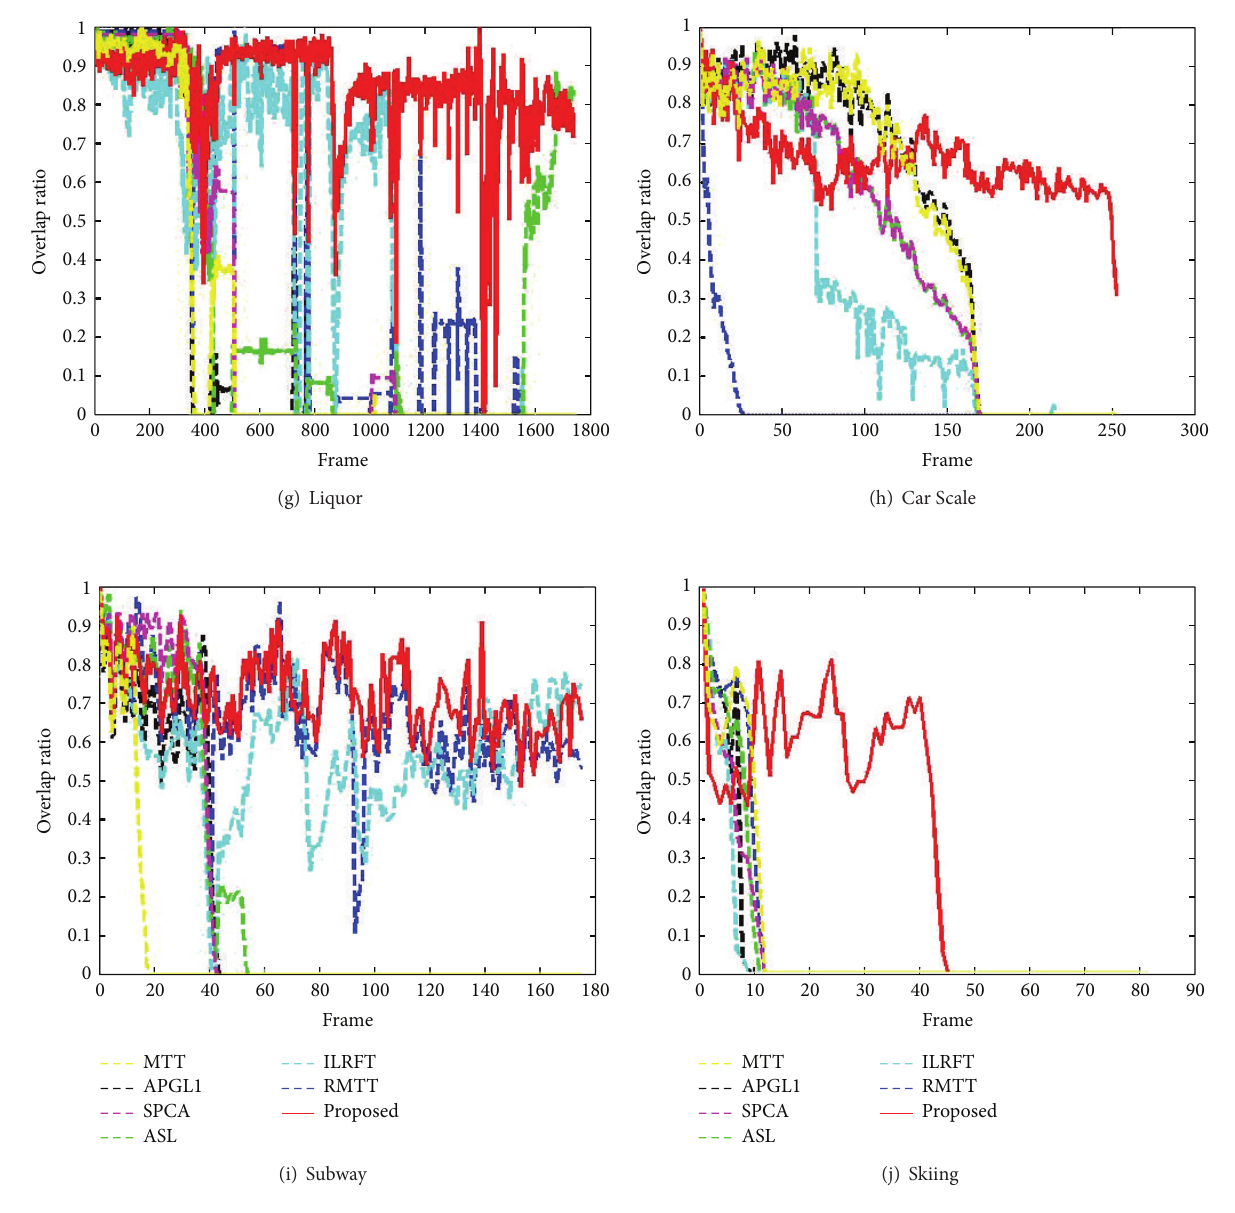
Figure 2: Overlap ratio evaluation. This figure shows overlap ratios for ten test sequences. The proposed method is compared with six state- of-the-art